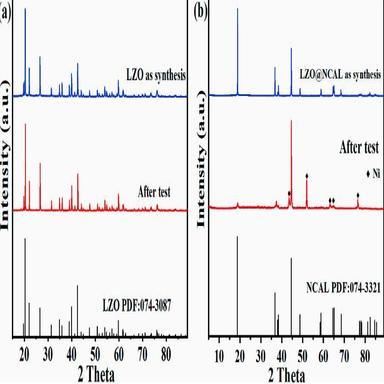
XRD patterns of (a) LZO samples before and after test at 550 ◦C in H2; (b) 1 wt % LZO@NCAL samples before and after test.